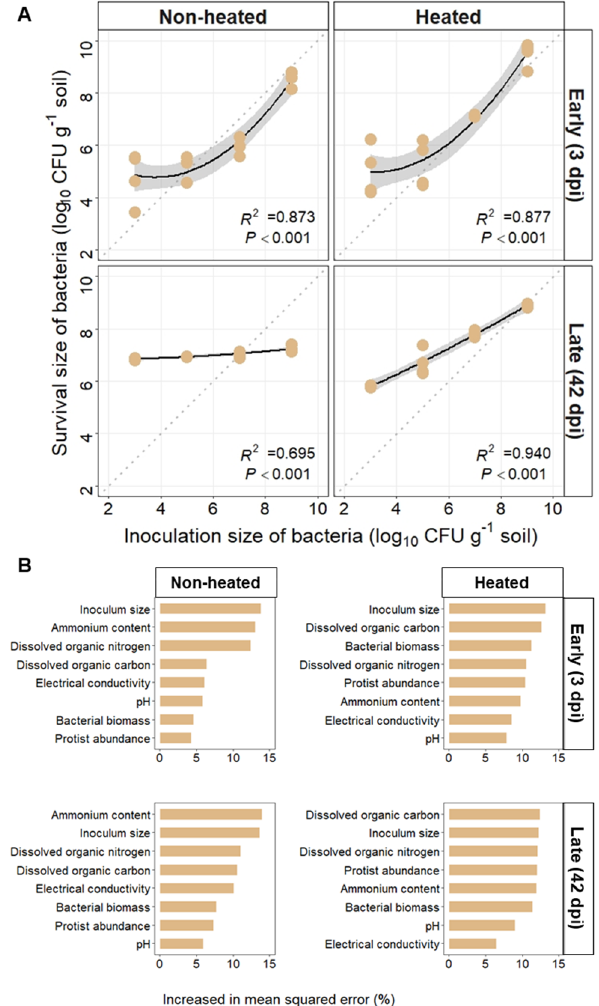
Figure 2. Dose–response curves for the survival of Ralstonia solanacearum in non-heated and heated soils at early (3 days post-inoculation, 3 dpi) and late (42 days post-inoculation, 42 dpi) stages; the values are log-transformed in the main figure ( A ). Shaded areas represent the 95% confidence intervals. The predictors for the survival of R. solanacearum in non-heated and heated soils at early (3 days post-inoculation, 3 dpi) and late stages (42 days post-inoculation, 42 dpi) were estimated by Random Forest, with the bars representing the increased percentage in the mean squared errors ( B ).